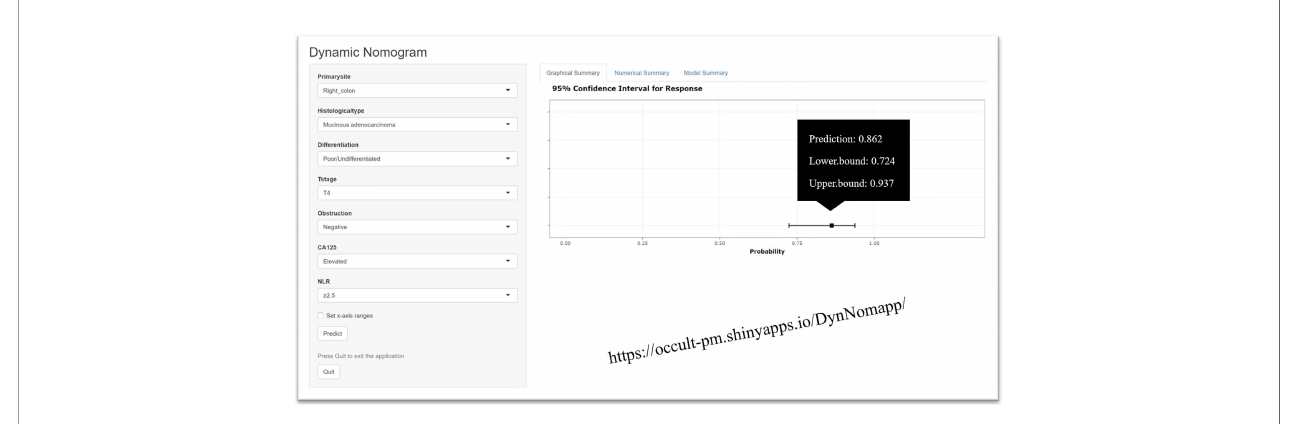
FIGURE 4 | Webserver display of the dynamic online platform.